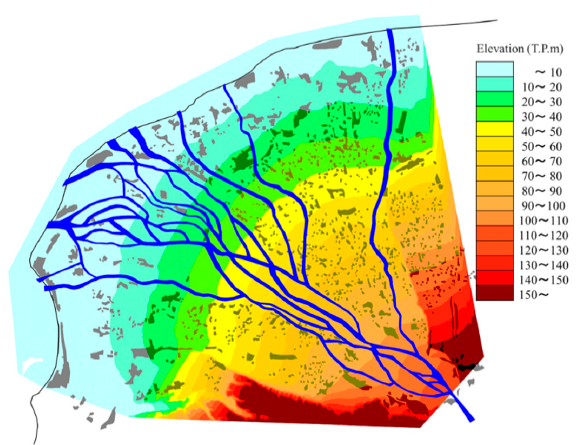
Figure 6. Topography of Kurobe Alluvial Fan in the 18th century.